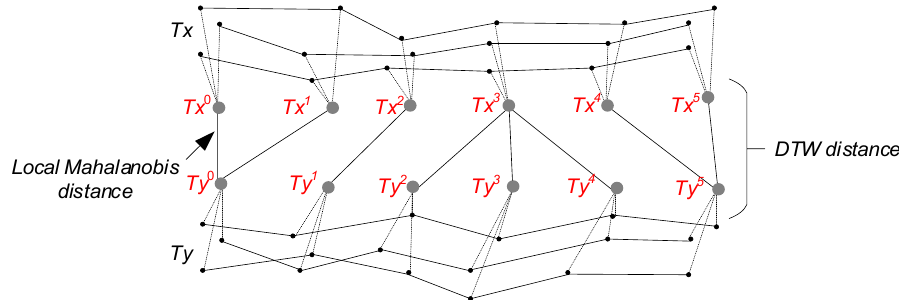
Figure 4. The optimal path of the DTW and the local Mahalanobis distance.